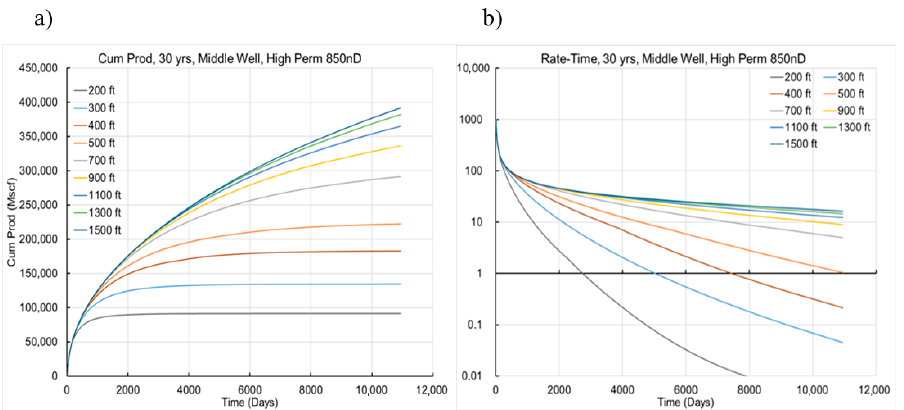
Figure 5. Well performance curves generated for Utica wells with a numerical reservoir simulator by ResFrac for well spacing ranging between 200 and 1500 ft. The base case performance is for the history matched Utica type well with 55 ft fracture spacing, and an assumed 1100 ft well spacing. The impact of wider and narrower well spacing on well productivity is graphed for both ( a ) the cumulative, and ( b ) daily production rates (data from Reference